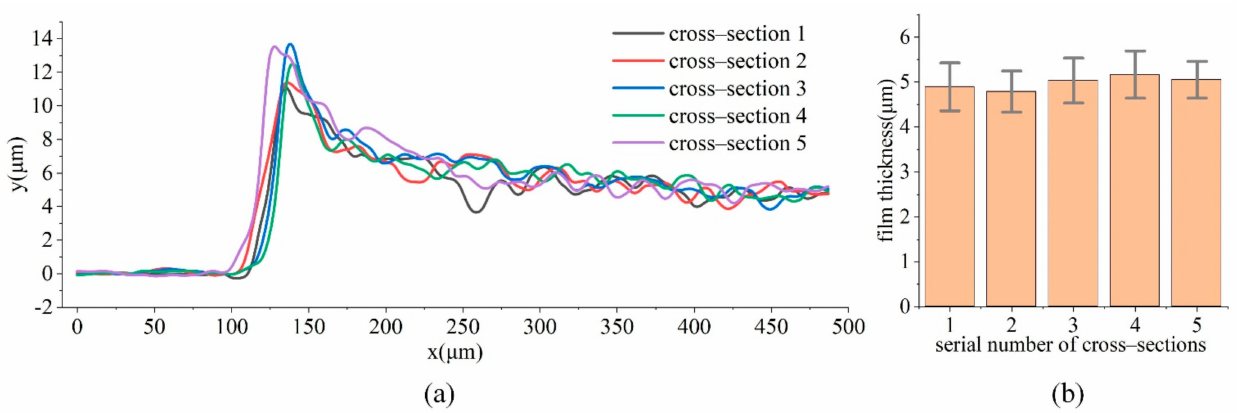
Figure 7. ( a ) The thickness of five cross-sections of the film; ( b ) Average thickness of the film between 350–450 µ m in the x -axis position.